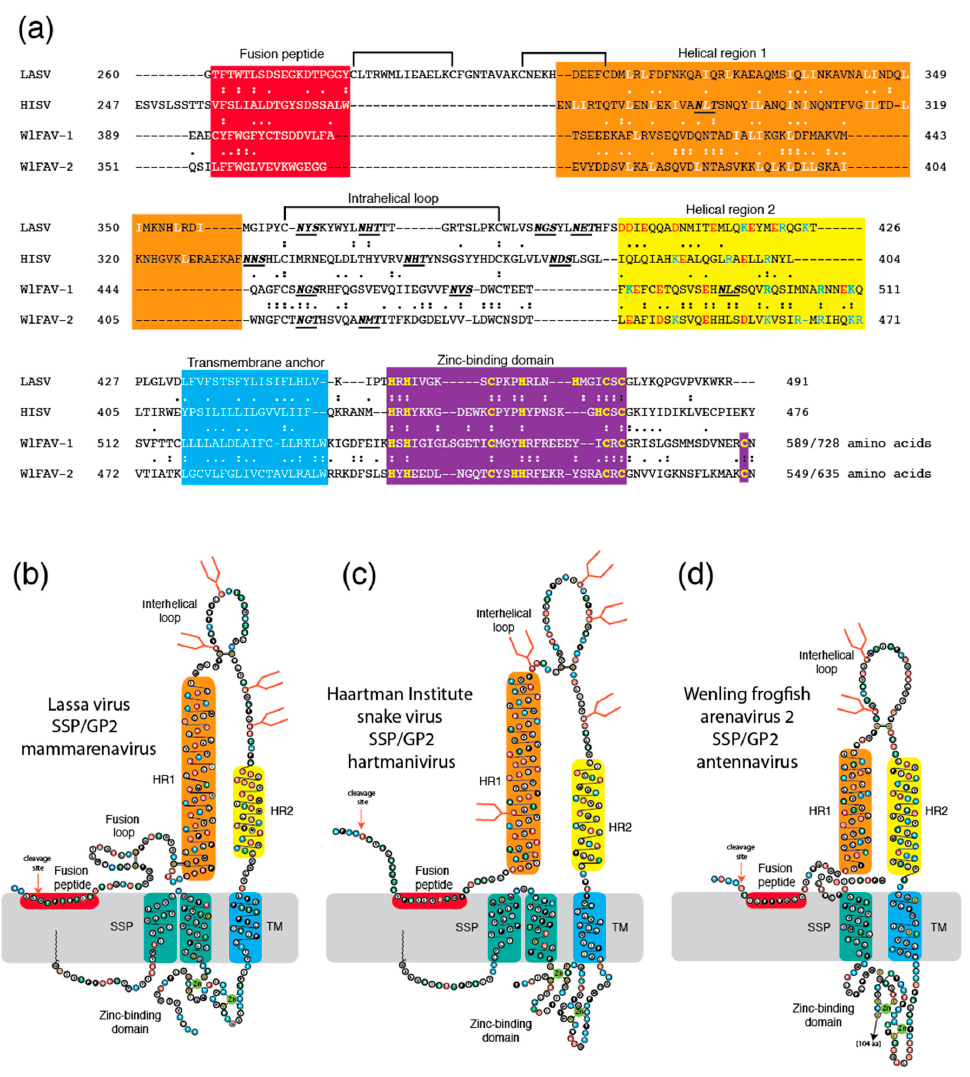
Figure 1. Comparisons of glycoproteins from representative members of three arenavirus